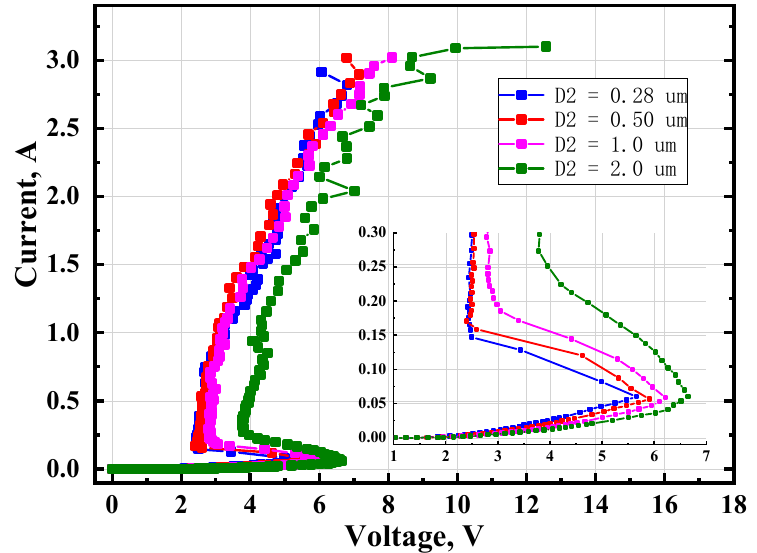
Figure 8. TLP test results of MTSCRs with four different D2.